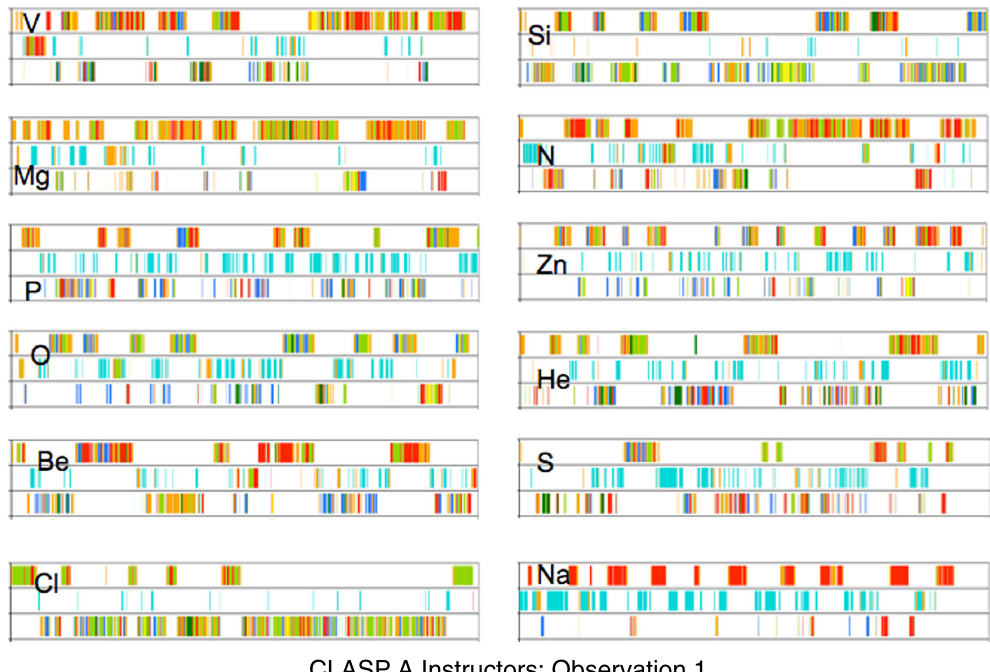
FIG. 7 (color online). Twelve different instructors teaching the same set of activities. The top row represents whole class time, the bottom row is small group time, and the middle row represents the interactions that take place during small group time, but when the instructor is addressing the class as a whole. Time is on the x axis. The colors are consistent with those in Fig. 1.